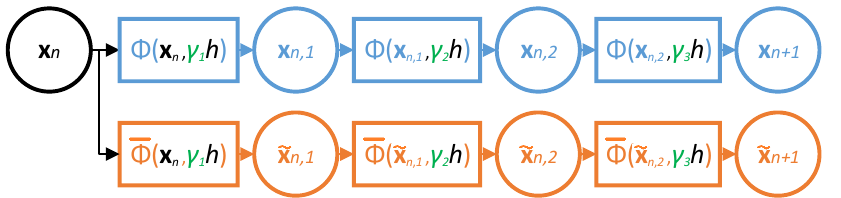
Figure 1. Scheme of OCDM algorithm. 𝐱 𝑛+1 is the main solution and 𝐱̃ 𝑛+1 is the additional solution introduced for error estimation.